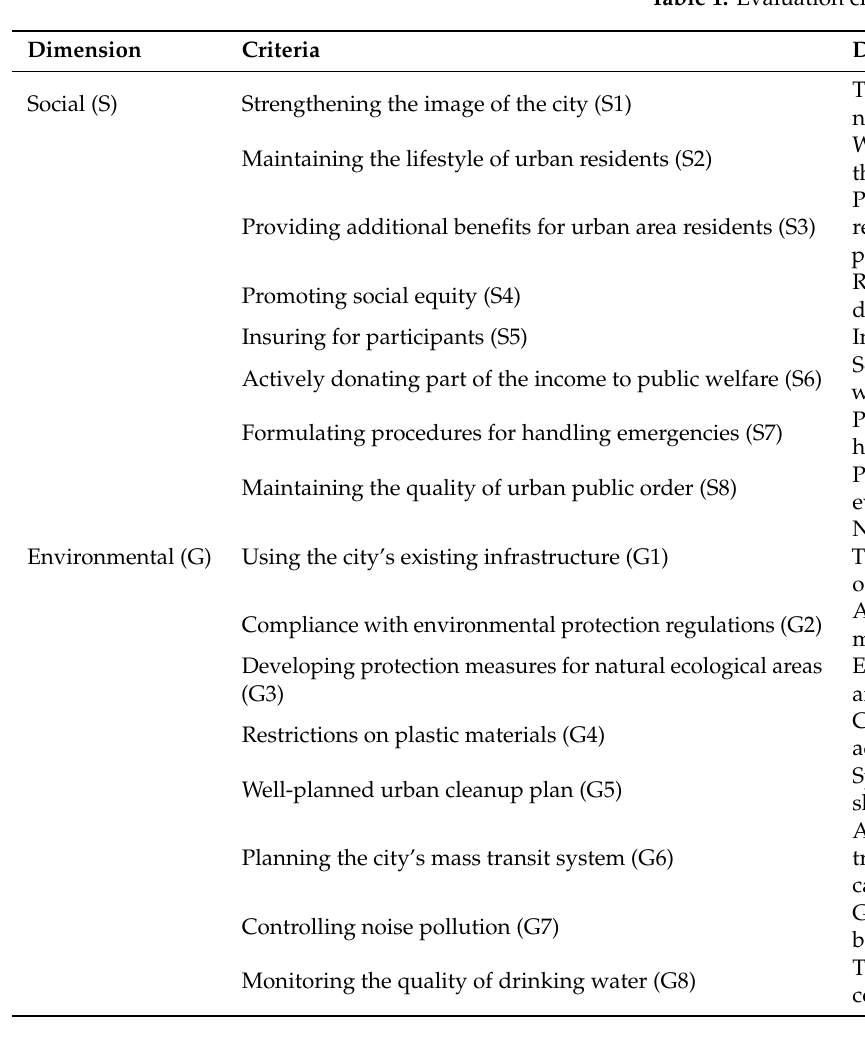
Table 1. Evaluation criteria and